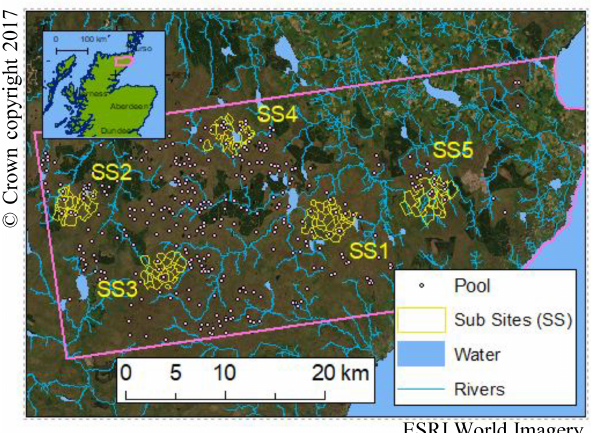
Figure 1. The study location (inset) and true colour satellite im- age composite covering the study area, outlined, in the Flow Coun- try, northern Scotland. Forested areas are dark green; more inten- sive agriculture appears as lighter greens to the north-east, with the remainder of the image mostly consisting of blanket bog.